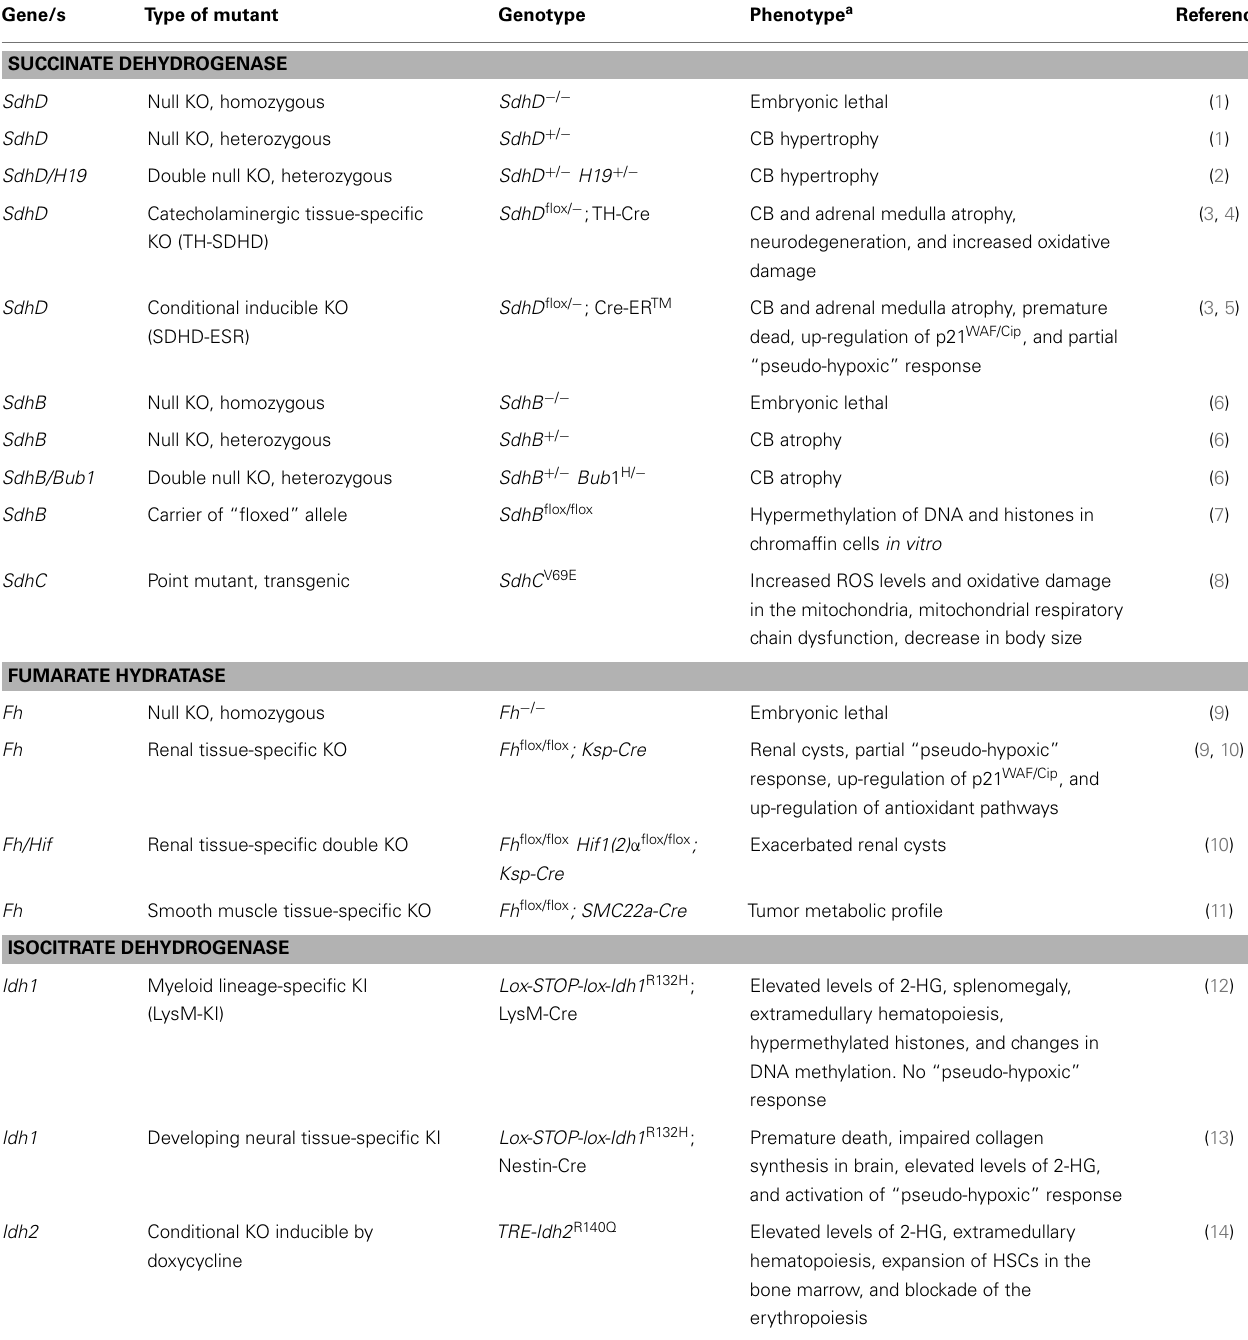
Table 1 | Summary of “knock-out” (KO) and “knock-in” (KI) mouse models